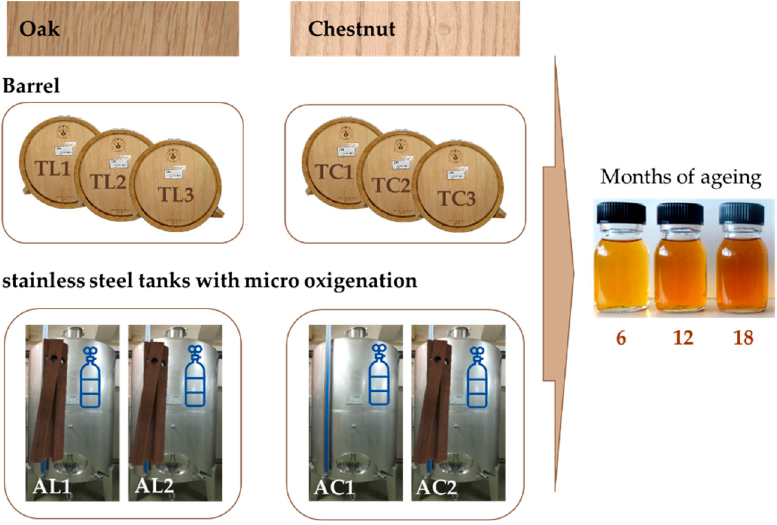
Figure 1. Scheme of the essay. 1, 2, and 3 indicate the essay replicates.